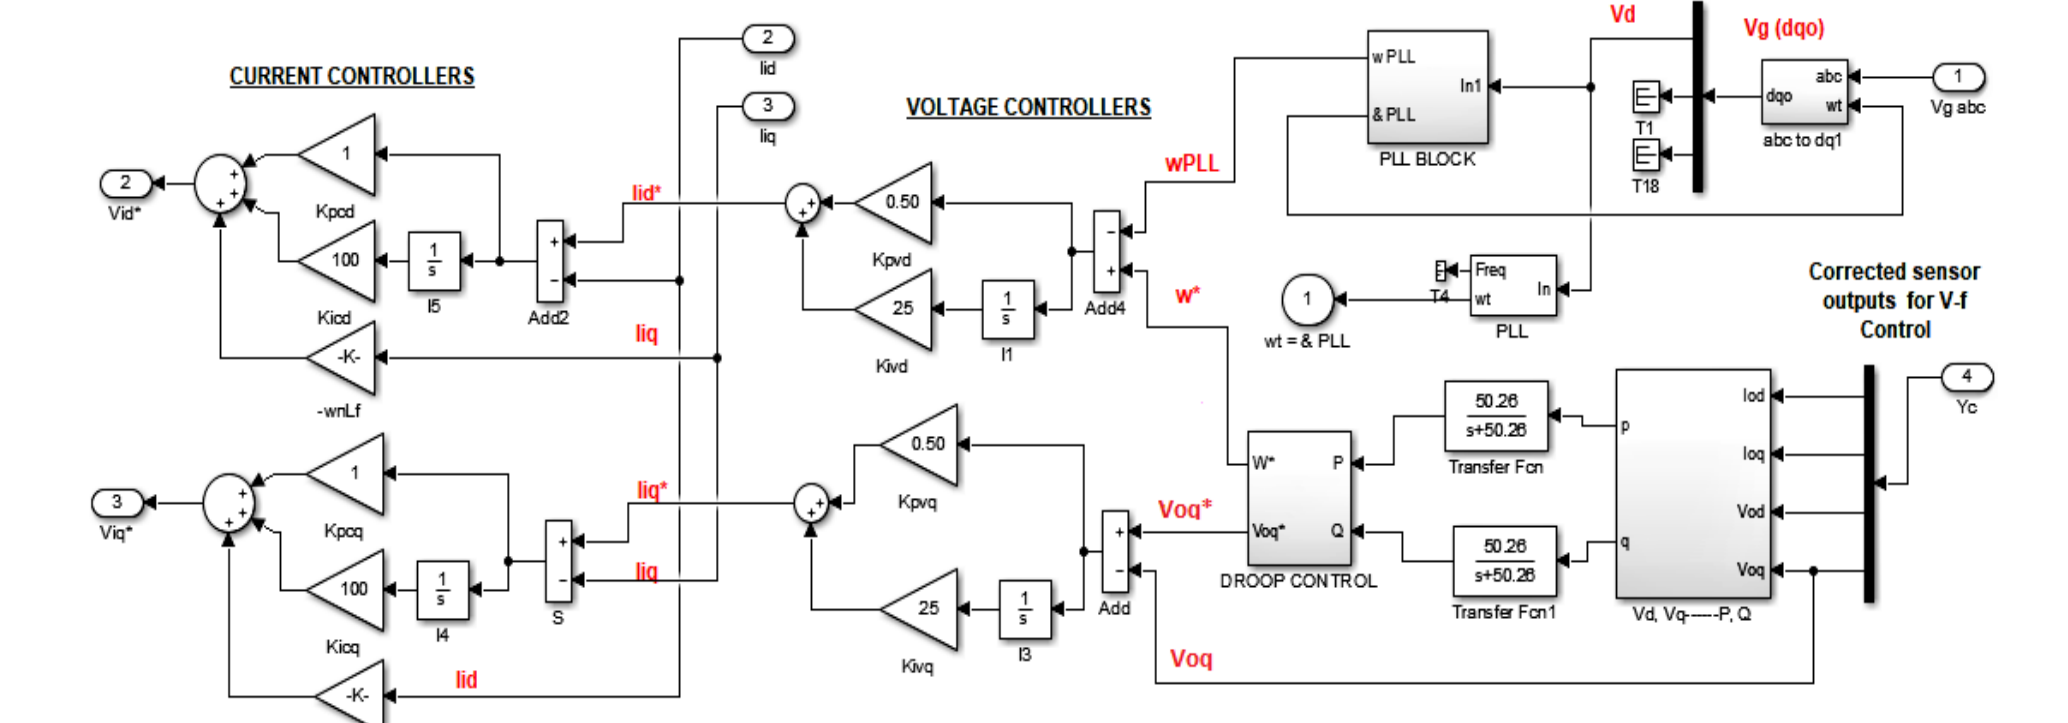
Figure 3. PI and droop control for voltage-frequency